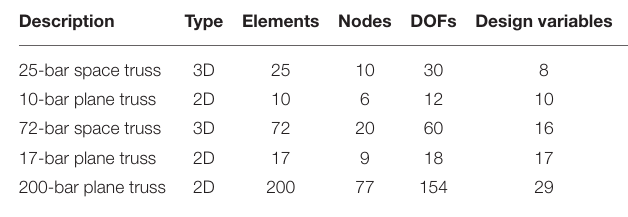
TABLE 1 | Characteristics of the five test